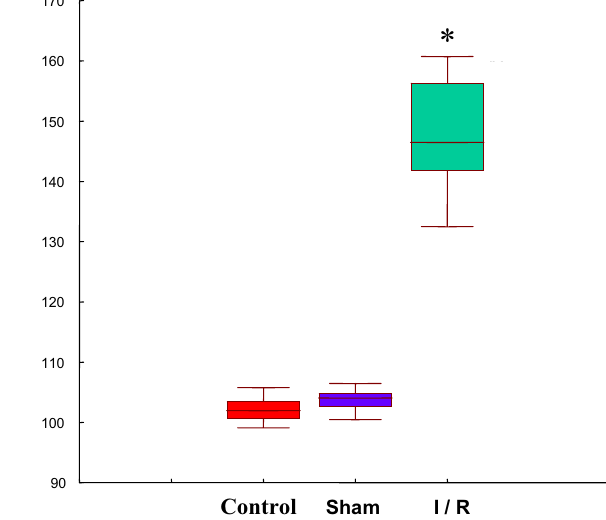
FIGURE 2 - The Box-plots show the variation of carbonyl protein content levels (optical density). The horizontal line in the box shows the results of median for groups Control, Sham and Ischemia/Reperfusion (I/R), respectively 101, 104 and 146. Vertical lines in the box represent the maximum (max) and minimum (min) values. The boxes contain 25-75% of the experimental data. In group 1 (G1), Control, the 95% confidence interval for mean was 96.29 through 107.0 (max = 105 and min = 99) and the average absolute deviation from median was equal to 1.62. Group 2 (G2), Sham, had a 95% confidence interval for mean ranging from 97.94 through 108.6 (max = 106 and min = 100) and the average absolute deviation from median was equal to 1.50. The Ischemia/ Reperfusion group (G3) showed a significant increasing of carbonyl level with p< 0.05 (*) with 95% confidence interval for mean from 142.0 thru 152.7 (max = 160 and min = 132). The average absolute deviation from median was